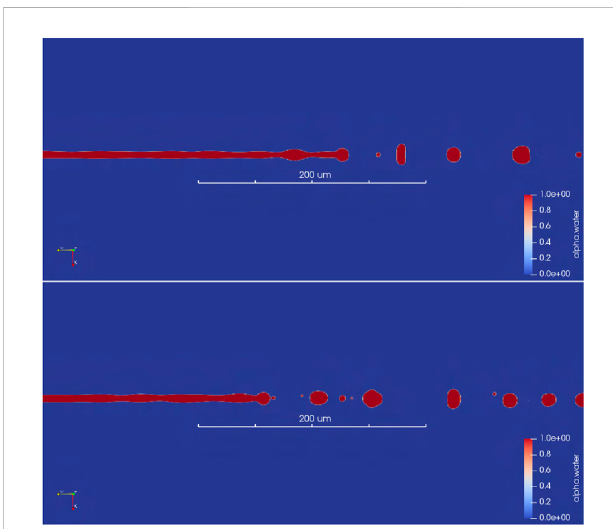
FIGURE 23 Simulation generated magnitude of the velocity vector fi eld in m / s along with the dynamic computational grid around the ori fi ce of the GDVN. This negative y -direction is the direction of jet propagation.